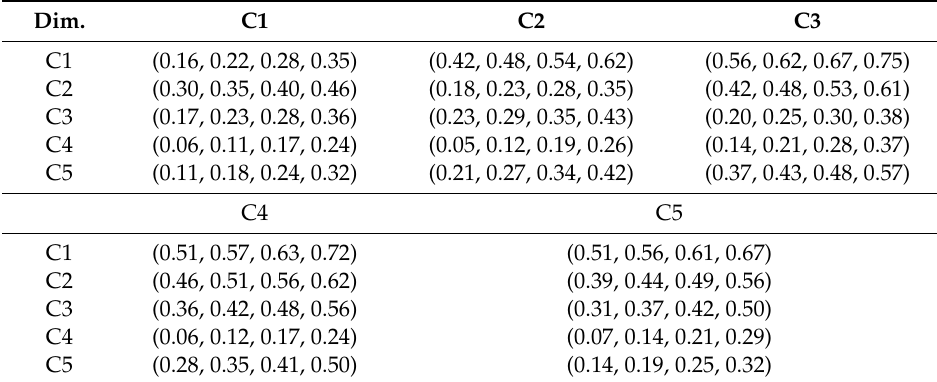
Table 7. Total fuzzy influence matrix.